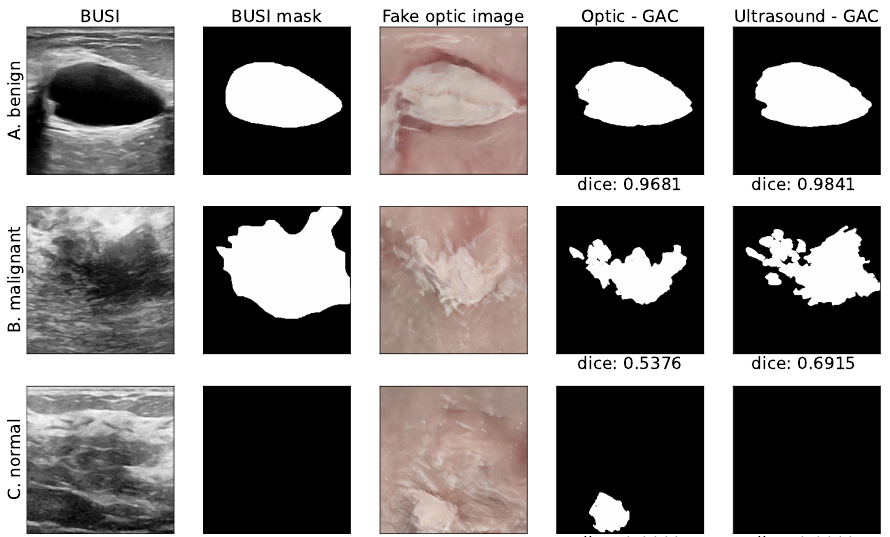
Figure 3. (1st column) Examples of the BUSI images. (2nd column) BUSI masks. (3rd column) The model-generated pseudo anatomical images. (4th column) The corresponding segmented masks obtained by MorphGAC for the pseudo anatomical images and for the original ultrasound images (5th column), with their Dice scores. The rows correspond to: ( A ) benign, ( B ) malignant, ( C ) normal. As can be noted, in these cases, the algorithm was less